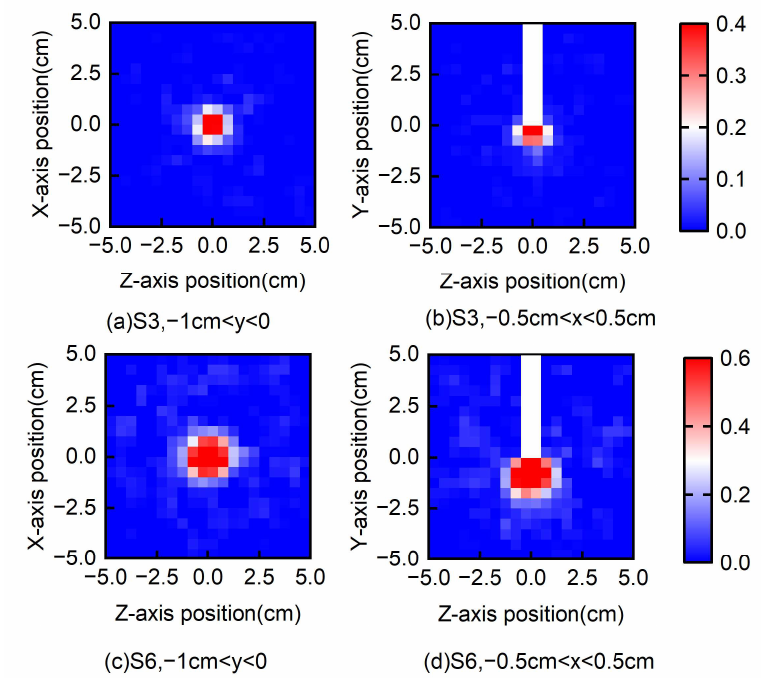
Figure 9. Local porosity